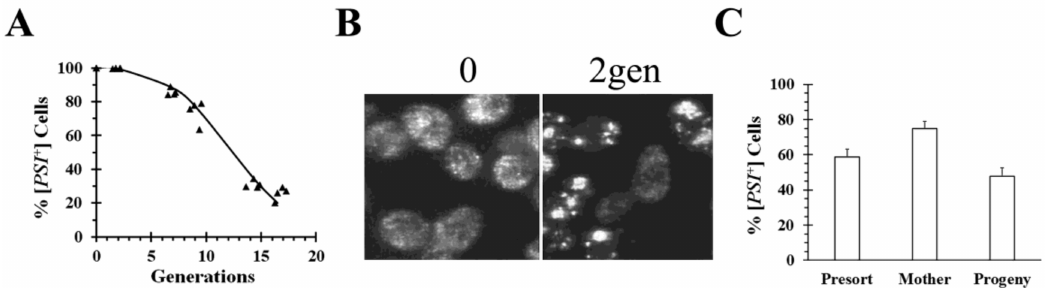
Figure 3. Curing of [ PSI + ] in SY80 yeast strain by overexpression of a S. pombe Hsp104 fragment, Hsp104 ∆ C32. ( A ) Time course of curing [ PSI + ] as a function of generation time. ( B ) Images of the GFP-labeled Sup35 in SY80 before induction and after inducing S. pombe Hsp104 ∆ C32 expressing for 2 generations with galactose. ( C ) Flow cytometry analysis of curing of [ PSI + ] in SY80 strain expressing S. pombe Hsp104 ∆ C32 for 6 generations. Cell wall was fluorescently labeled with wheat germ agglutin, as described previously [34], mother cells were then separated from progeny based on fluorescent labeling by flow